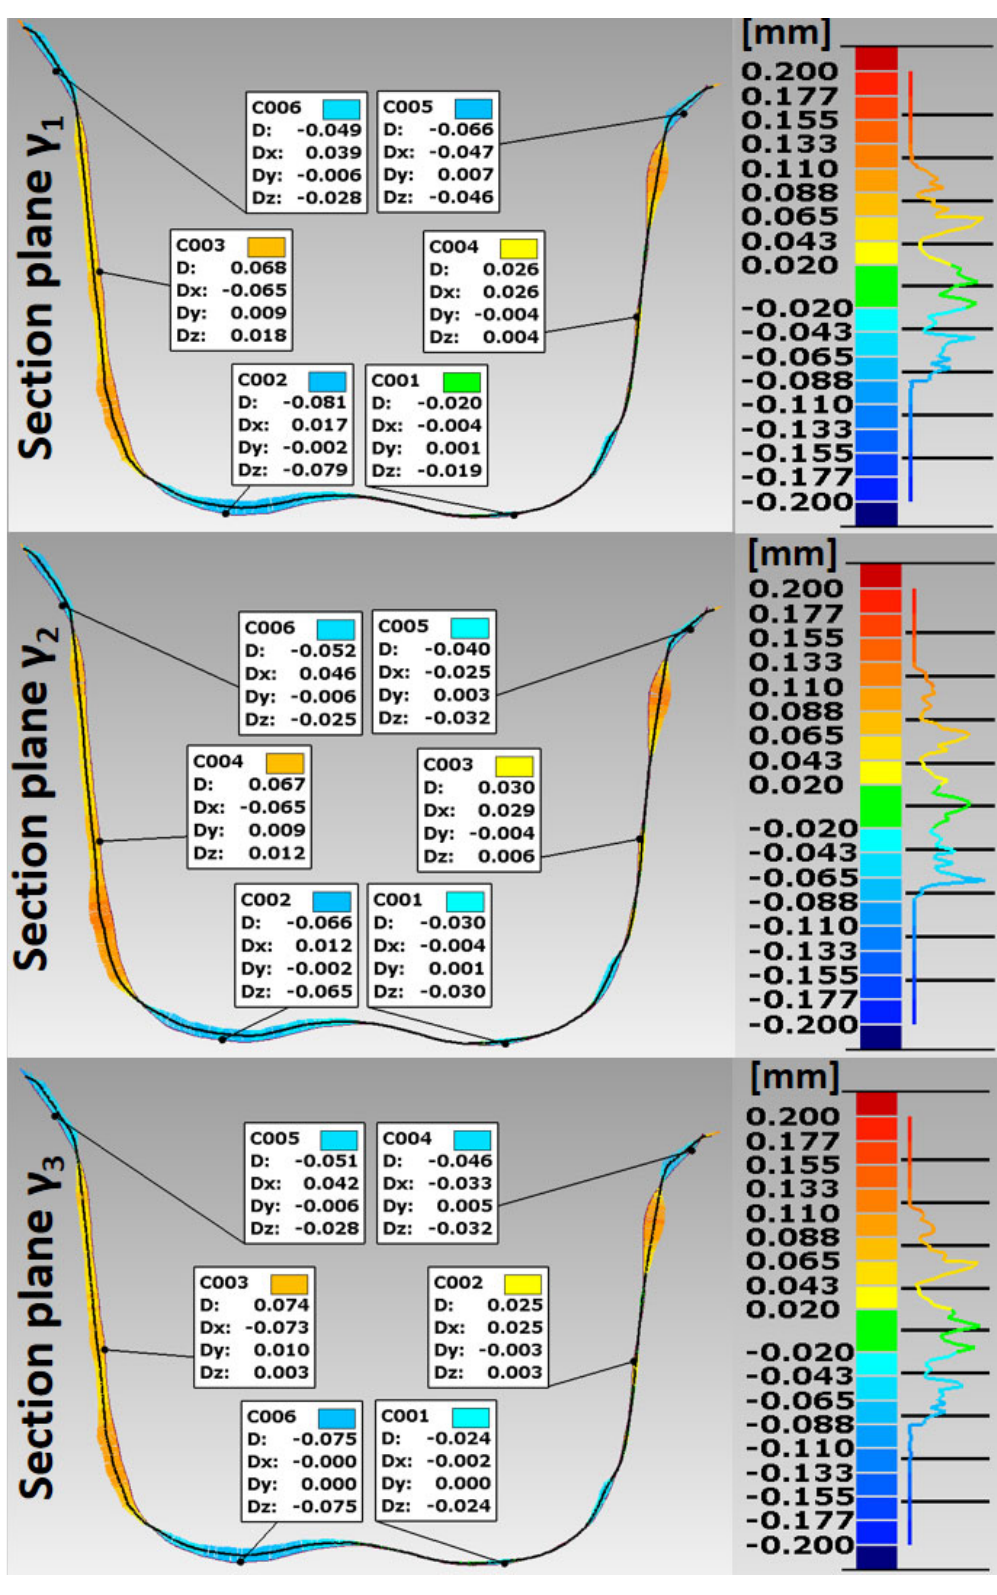
Figure 13. Distribution of deviations in the marginal and internal fit of a crown made of Ti6Al4V alloy in milling for premolar 15.